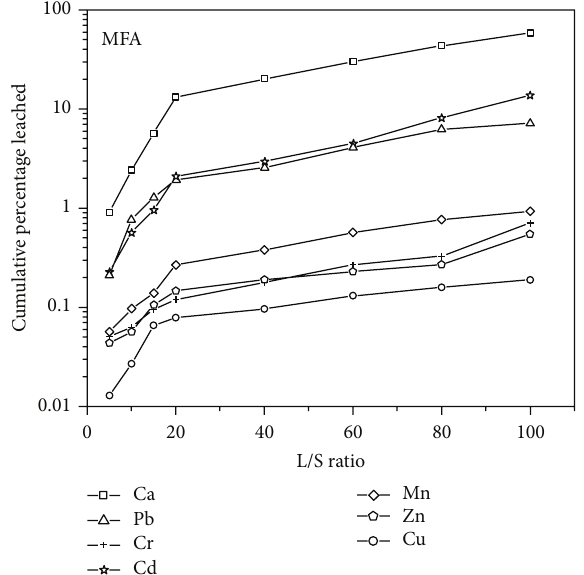
Figure 11: Cumulative percentage of various elements leached from MFA.